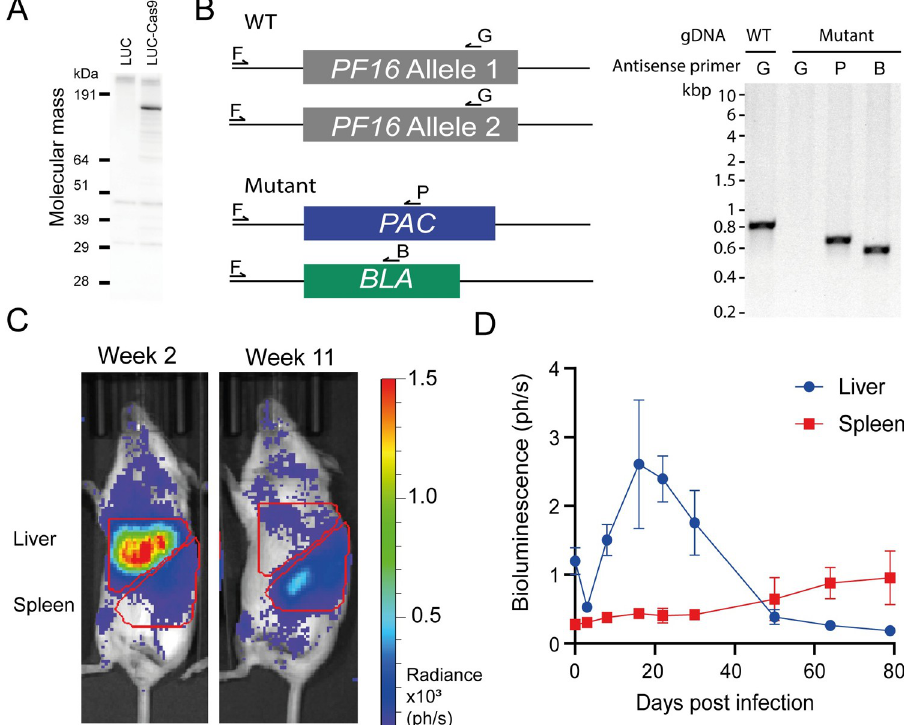
Fig 1. Selection and characterization of a virulent bioluminescent L . donovani cell line expressing SpCas9. ( A ) Stable expression of a FLAG-tagged Cas9 nuclease in a bioluminescent L . donovani parasite line (LUC). Total cell lysates from 5x10 6 L . donovani promastigotes were resolved by SDS-PAGE under reducing conditions, blotted, and detected with an anti-FLAG antibody. ( B ) Schematic of diagnostic PCR to demonstrate expected targeting, gDNA from wild type (WT) or doubly-drug resistant (mutant) parasites is amplified using a shared sense primer (F) and specific antisense primers targeting the gene of interest (G), PAC (P) or BLA (B) (left panel). Products from a diagnostic PCR demonstrating replacement of the endogenous PF16 gene in L . donovani using Cas9 genome editing. Primers specific for the endogenous PF16 locus (primers F and G) amplified a product of the expected size from genomic DNA from the parental (lane 1) but not the drug-resistant parasites (lane 2); targeted integration into the PF16 locus was demonstrated with shared and drug-specific primers (P and B) for the puromycin (lane 3) and blasticidin resistance genes (lane 4) respectively (right panel). ( C ) Representative images of mice infected with Ld- LUC-T7-Cas9 at weeks 2 and 11 post infection including the gating strategy to quantify parasitemia in the liver and spleen. ( D ) Virulence of the Ld-LUC-T7-Cas9 line in an experimental murine infection model. Groups of 3 to 5 female BALB/c mice were infected with stationary phase promastigotes of the Ld-LUC-T7-Cas9 line and parasitemia in both liver and spleen quantified using bioluminescent imaging. Data points represent means ± s.d. Data are from a representative experiment. Each unit of bioluminescence represents 1 x 10 5 photons per